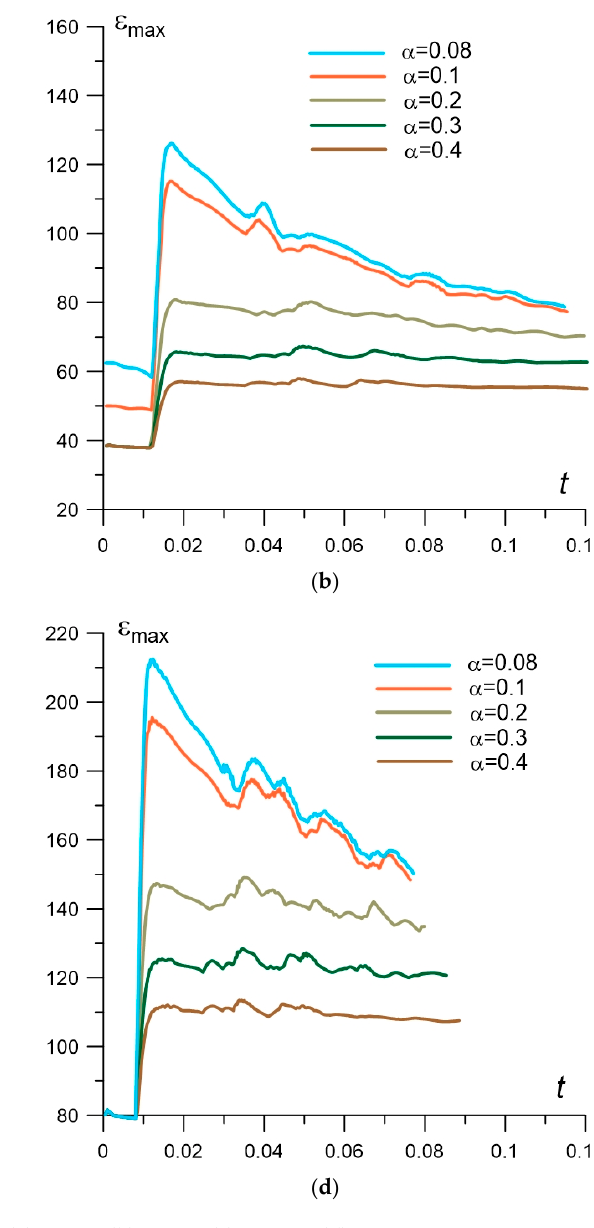
Figure 10. Dynamics of ε max for different α : ( a ) M = 6; ( b ) M = 8; ( c ) M = 10; ( d ) M = 12.